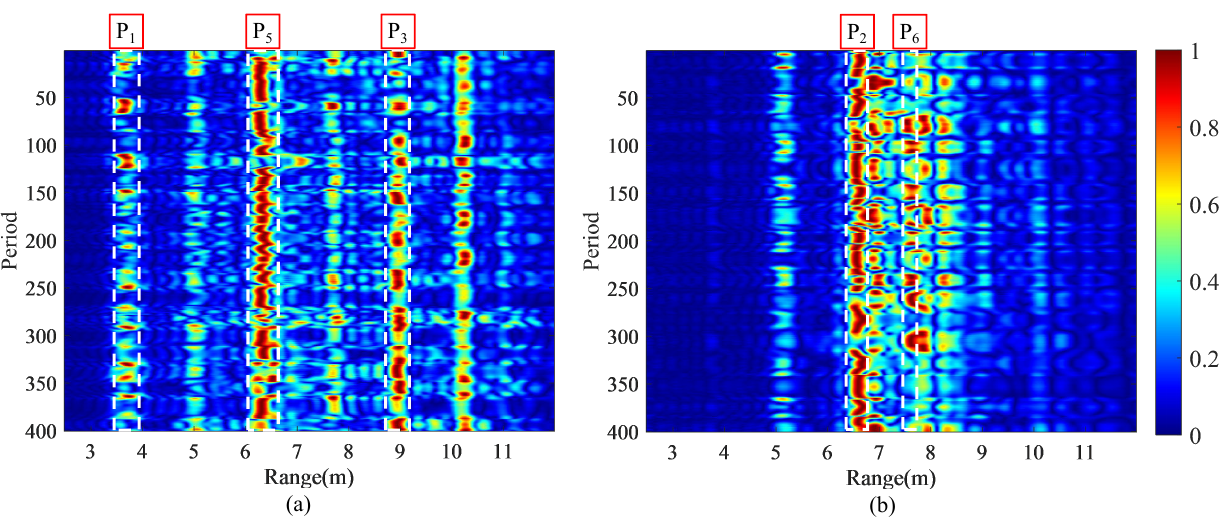
Figure 10. Dual-view range profiles for single target. ( a ) Range profile of View 1. ( b ) Range profile of View